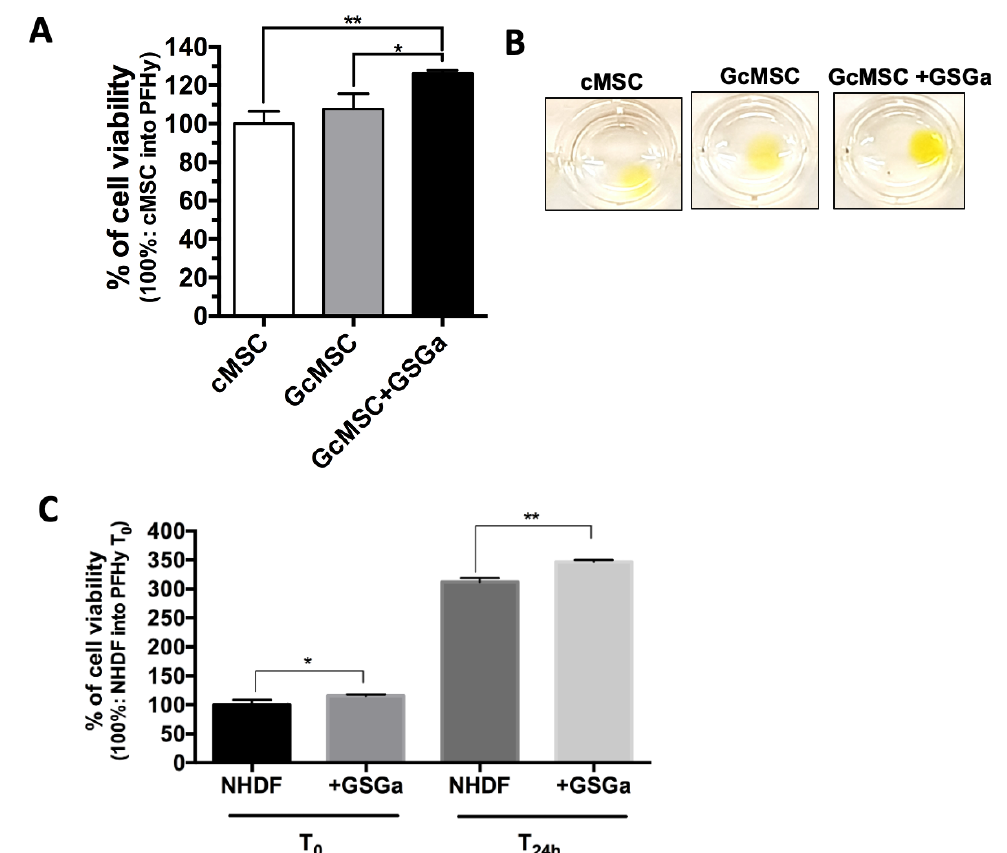
Figure 5. Protection from photo-polymerization damage by GSGa long-term pre-treatment in a 3D cMSC culture system and by GSGa short-term pre-treatment in 3D NHDF culture system. ( A ) WST-1 cell viability assay after PFHy polymerization on stem cells pre-treated for one month with GSGa (140 µ g/mL) (GcMSC) and further treated for three days with GSGa (680 µ g/mL) (GcMSC+GSGa) before embedding; 100% viability is represented by untreated cMSC embedded in the hydrogel; ( B ) digital images of the hydrogels after WST-1 assay; ( C ) cell viability assay of NHDF and preconditioned NHDF for three days with GSGa (680 µ g/mL) (+GSGa) before embedding in PFHy for 3 h (T 0 ) and after 24 h (T 24h ). Each result was obtained from three independent experiments. Error bar indicates S.D. * p value ≤ 0.05; ** p value ≤ 0.01.